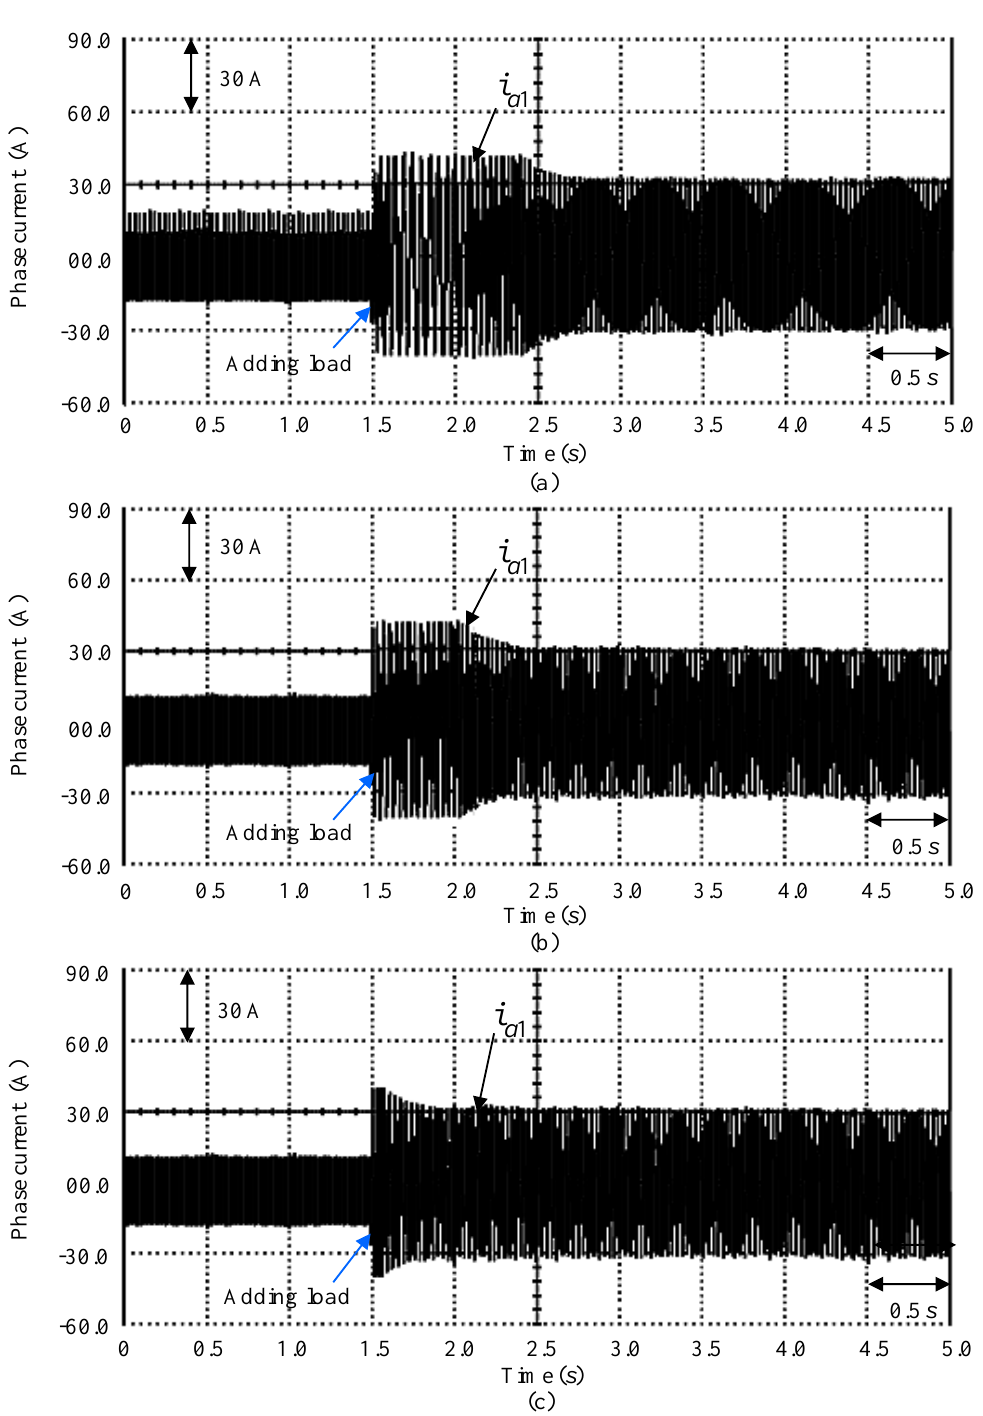
Figure 14. Tested instances with experimental results at the examination Y3 instance: ( a ) gauged phase current a 1 response obtained by using the controller CD1, ( b ) gauged phase current a 1 response obtained by using the controller CD2, ( c ) gauged phase current a 1 response obtained by using the controller CD3.